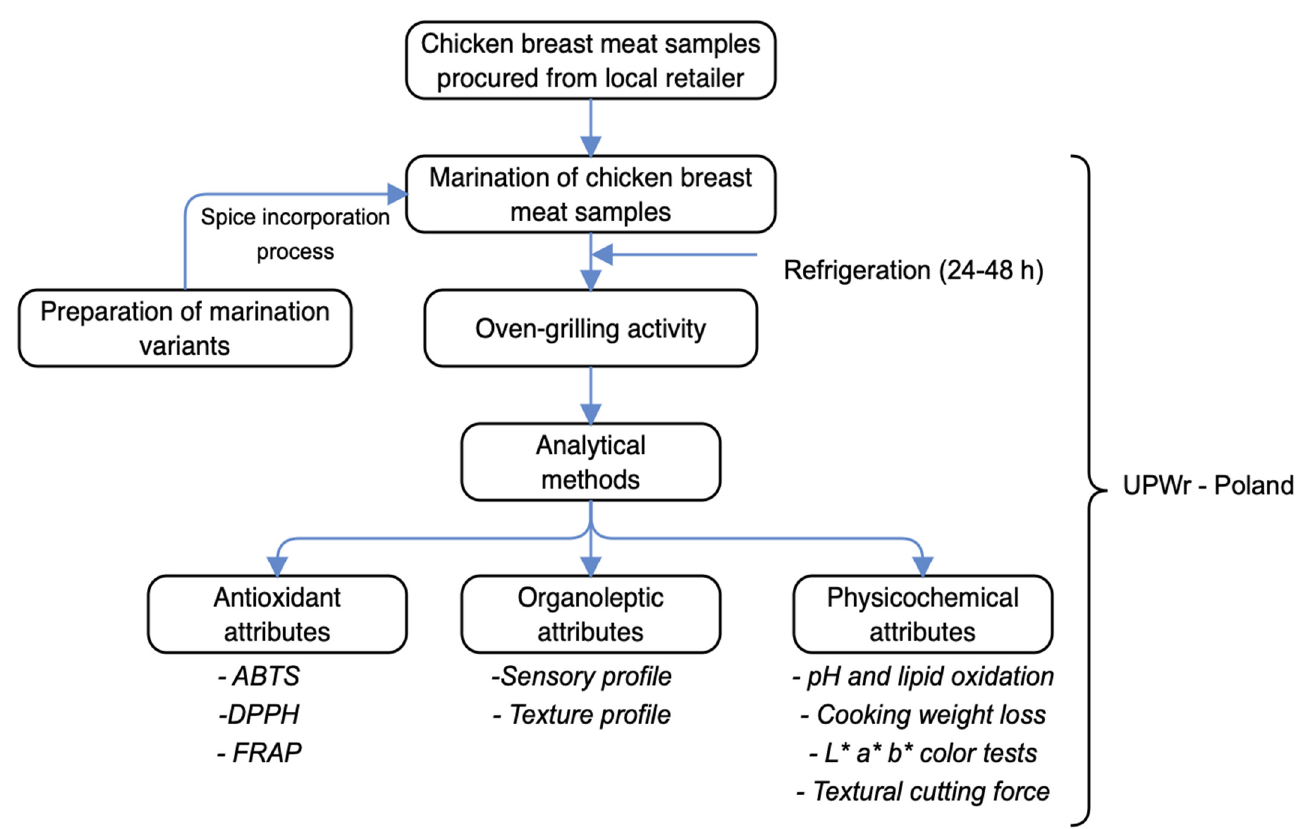
Figure 1. The schematic overview of the experimental program, which depicts the major stages, from the procurement of the chicken breast meat samples, preparation of marinade variants, through oven-grilling activity, and the subsequent analytical measurements. ABTS: 2,2 ′ -Azinobis- (3-ethylbenzthiazoline-6-sulphonate); DPPH: 1,1-diphenyl-2-pierylhydrazy (radical scavenging activity); FRAP: ferric-reducing antioxidant power; UPWr: Uniwersytet Przyrodniczy we